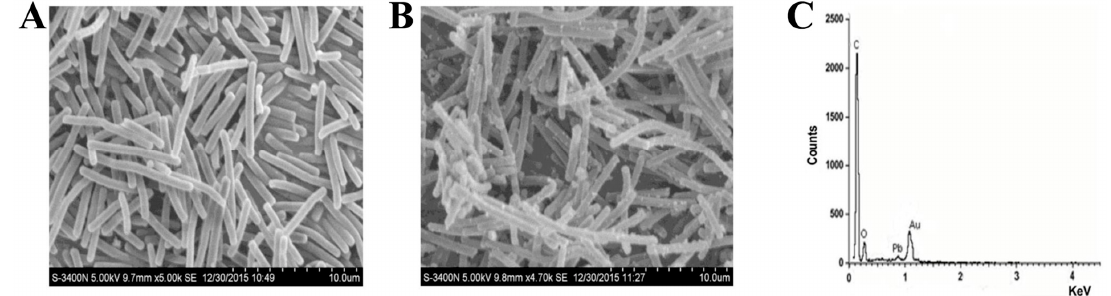
Figure 4. Scanning electron micrographs of L. bulgaricus KLDS1.0207 untreated and treated with Pb (50 mg/L): ( A ) Untreated biomass; ( B ) Biomass after lead binding; and ( C ) Energy dispersive spectrometer (EDS) analysis of biomass after Pb binding. Scale bar = 10.0 μ m.